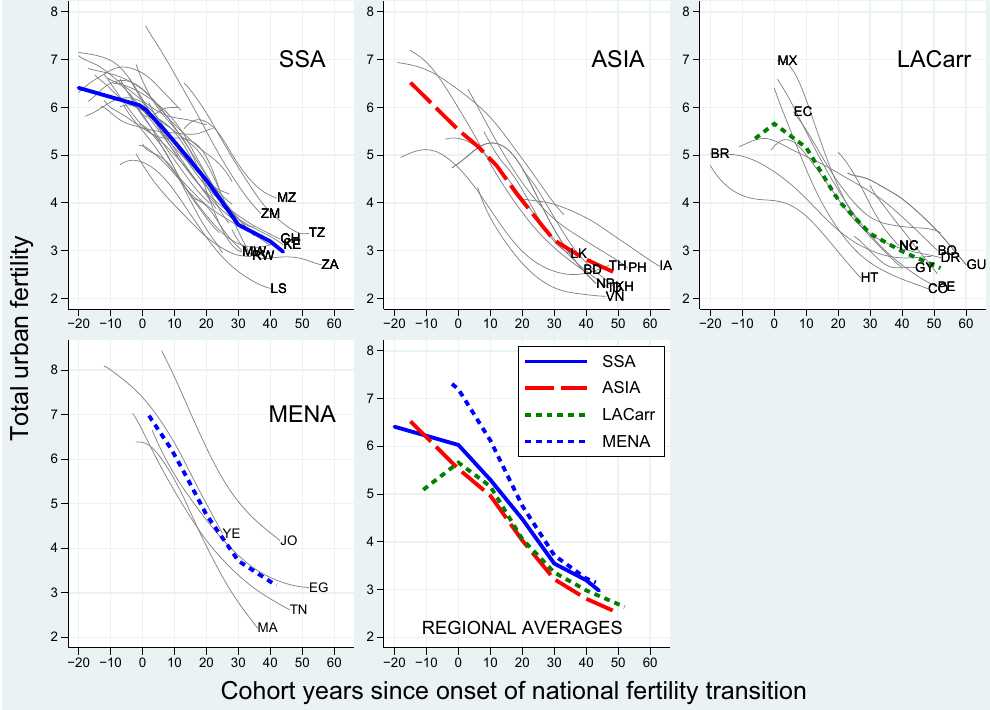
Fig 3. Average and country-specific trends in urban cohort fertility over the course of the national fertility transitions (onset = year 0), cohorts 1896–1982 in 60 African, Asian and Latin American countries. Source: WFS & DHS, MICS, IPUMS, UN historical and World Population Prospects estimates (2017). Notes: thick lines designate average within-country trends; LACarr = Latin America and the Caribbean, MENA = Middle East and Northern Africa, SSA = sub-Saharan Africa; see Table 1 in S1 File for country acronyms; the onset of the transition corresponds to the calendar year in which the national-level TFR peaked, which was then back-translated by the mean age at birth to get a cohort